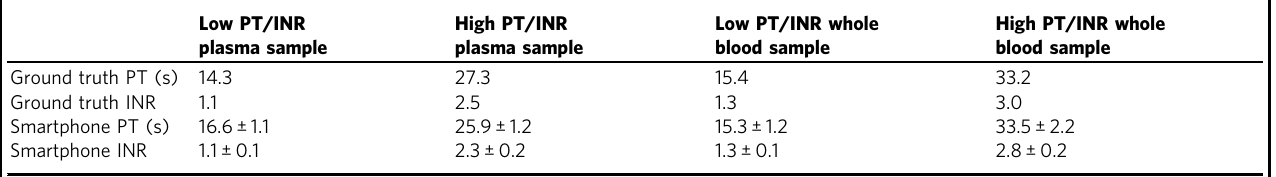
High PT/INR plasma sample